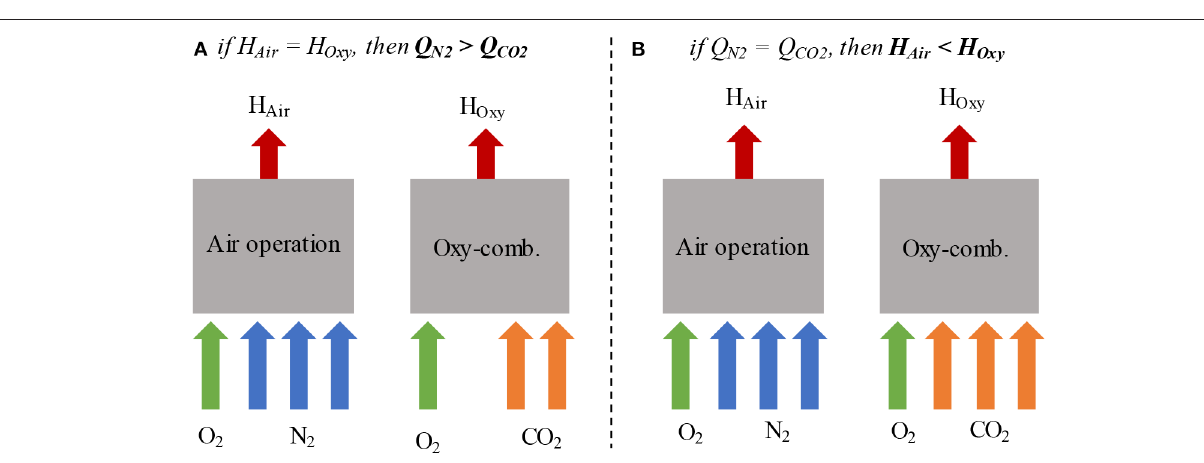
FIGURE 8 | Oxy-combustion and air operation in the (A) same heat balance and (B) same volumetric flow rate, adapted from Mello et al. (2013) with permission from